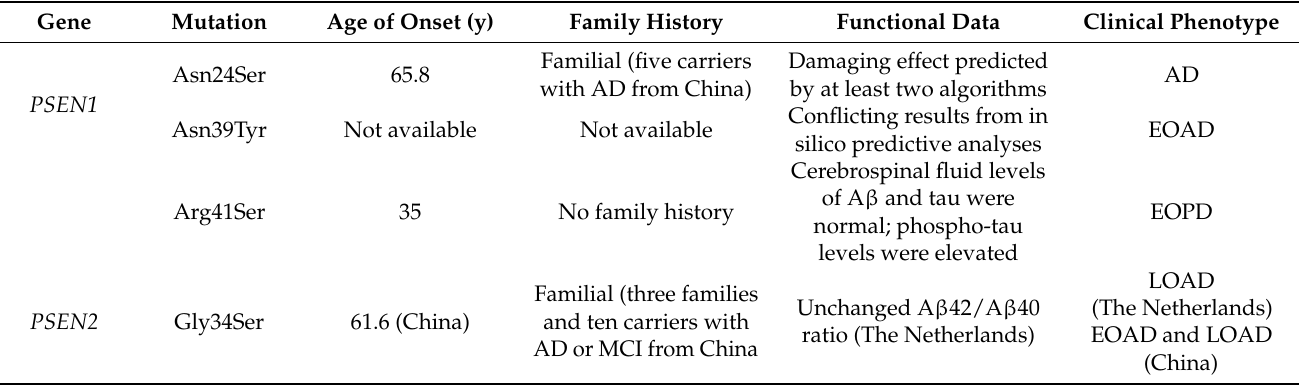
Table 1. Mutations substituted with phosphorylation-capable residues in the cytosolic N-terminal region of